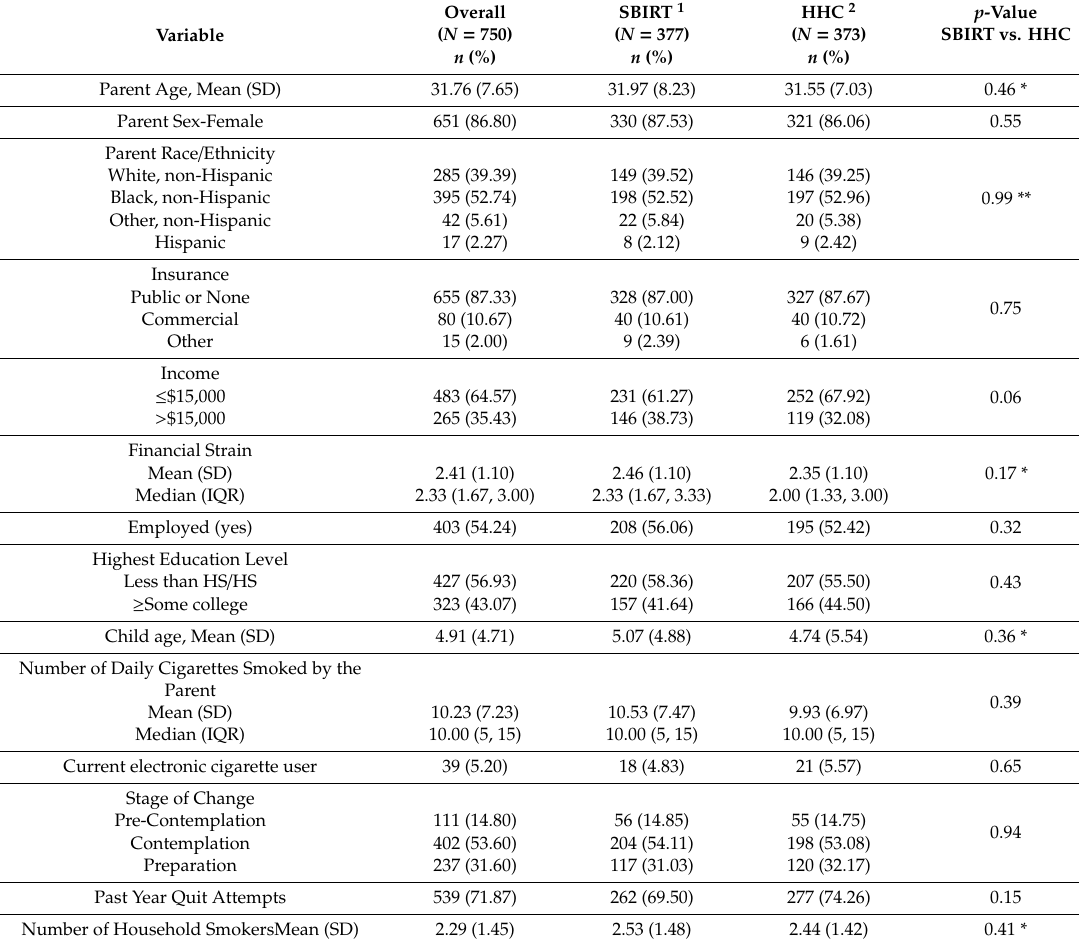
Table 1. Characteristics of the study population overall and by study